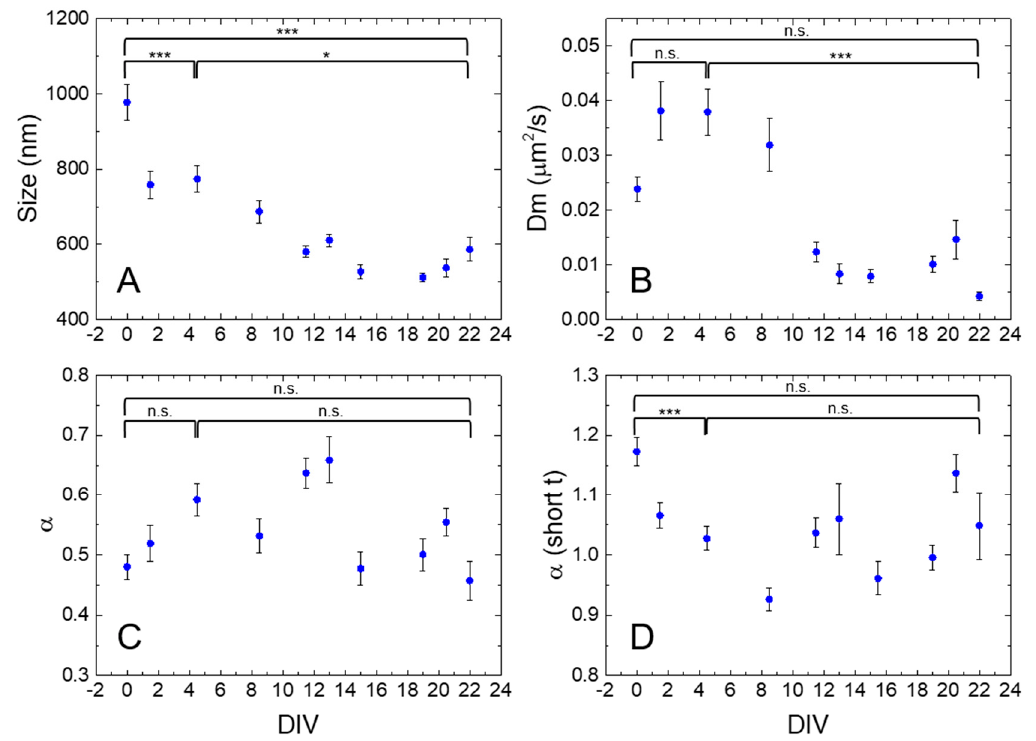
Figure 3. Plots of average size ( A ), D m ( B ), α ( C ), and α at short times ( D ) values extracted from i MSD analysis of NSC lysosome populations acquired during differentiation (DIV0-22). Error bars: Standard Error (SE). The population means of different time points for size, D m , α , and α (short t) are all significantly different by one-way ANOVA ( p < 0.0001). The results of the post hoc Tukey test are shown only for the comparisons amongst DIV0, 4.5, and 22; p-values: n.s. not significant, * < 0.05; *** < 0.001. Size, D m , α , and α (short t) average values with the respective DIV, N, and SE are reported in Table